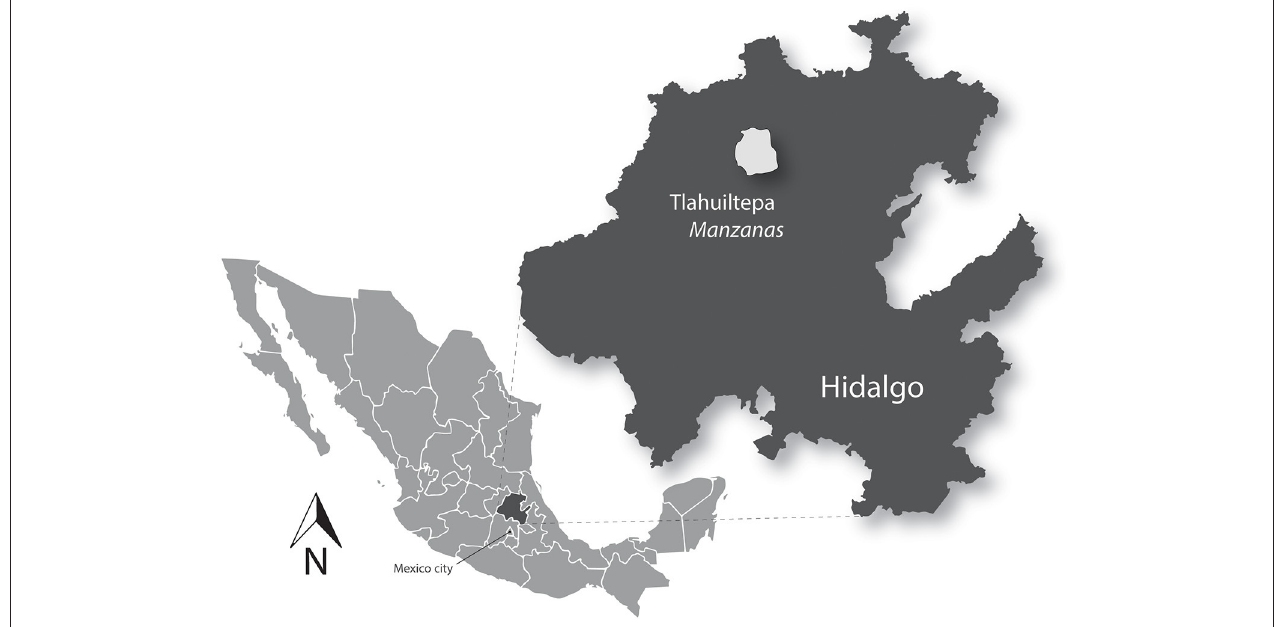
FIGURE 1 | Location of Manzanas on the map. Source: prepared by the authors.